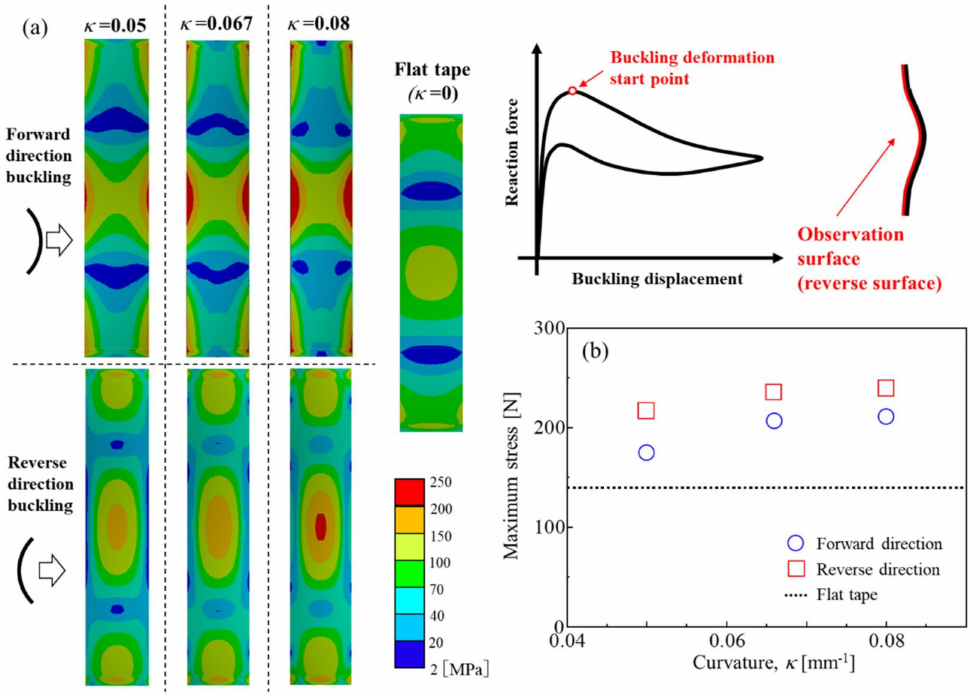
Figure 13. The numerically obtained ( a ) stress distribution and ( b ) κ dependence of maximum stress on the reverse surface of each specimen for each buckling direction at the buckling deformation start point.